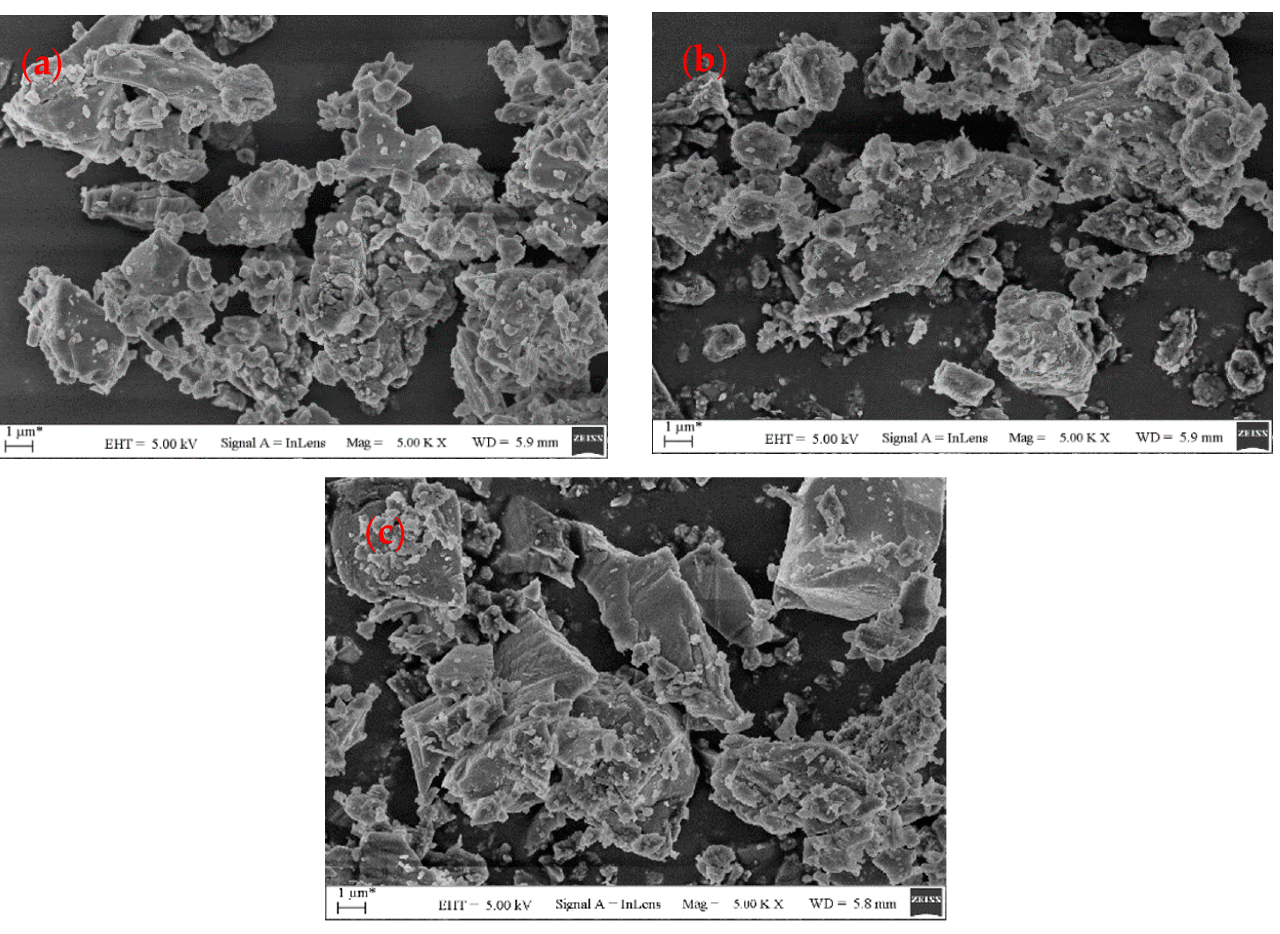
Figure 5. Morphology of mineral filler surface: ( a ) LP; ( b ) BP; and ( c ) GP.